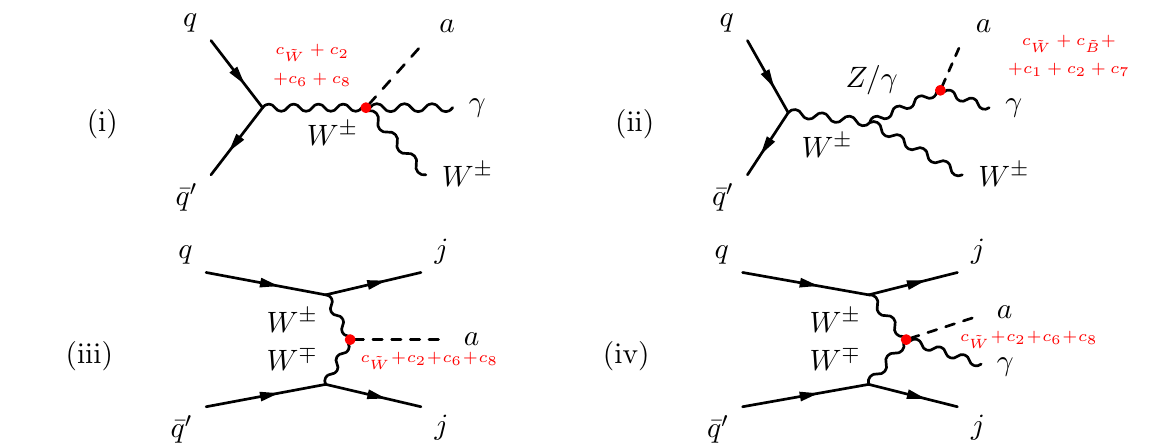
Fig. 6 Main diagrams contributing to the processes analysed in Sect. 7.2. Upper line a γ W associated production. Lower line VBF- type interaction producing ajj (iii) and ajj γ (iv). The proportionality